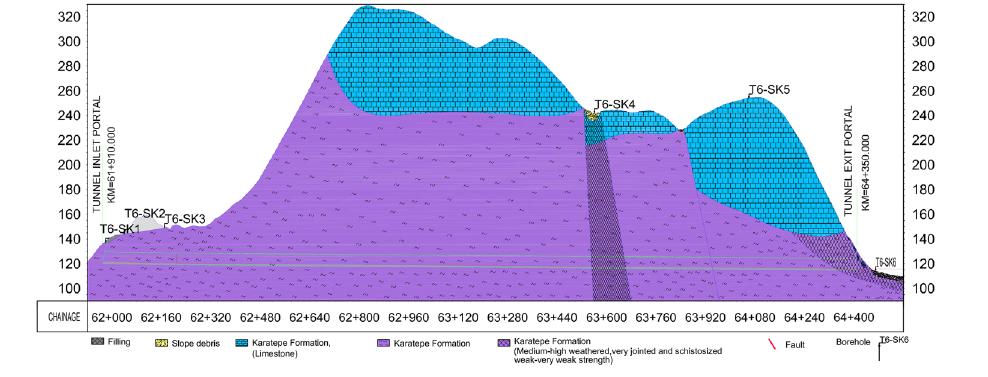
Figure 3. T6 tunnel geological and geotechnical profile 34 .